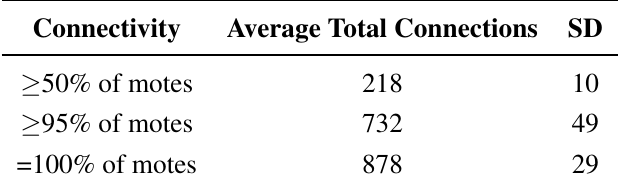
Table 2. The average number of established connections, over multiple simulation runs, at the point in time of achieving a given